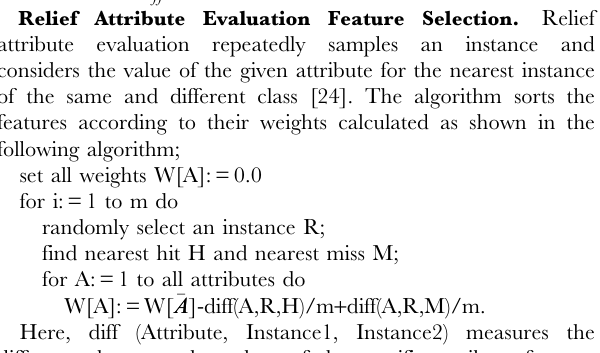
ROCK inhibitor and immunostained with E-cadherin (red) to label epithelium and Sybr Green (green) to label nuclei. The control SMGs show an outer layer of epithelial cells that is highly ordered (as marked with a dotted line below this cell layer) whereas the ROCK inhibitor-treated SMGs do not have this highly ordered cell arrangement (arrows). Scale,50 mM. Figure S2 Sublingual and submandibular glands are depicted. In our analysis, we manually discarded the sublingual regions of the samples, depicted with the dashed region in the figure, and only used the sub- mandibilar glands. Figure S3 Feature correlations for different tissue types are shown. Cell-graph feature correlations were clustered into four groups using the k-means clustering algorithm. Features that are highly correlated are grouped together. In (a) control epithelial tissues, (b) ROCK-inhibitor-treated epithelium, (c) control mes- enchymal tissue, and (d) ROCK inhibitor treated mesenchymal tissue correlation clusters are depicted. Figure S4 Statistically significant pair-wise correla- tions. Absolute values of the significant correlations for control epithelial tissues are shown in (a), ROCK inhibitor-treated epithelial tissues are shown in (b), control mesenchymal tissue in (c) and ROCK inhibitor-treated mesenchymal tissue in (d). Features are shown in numerical